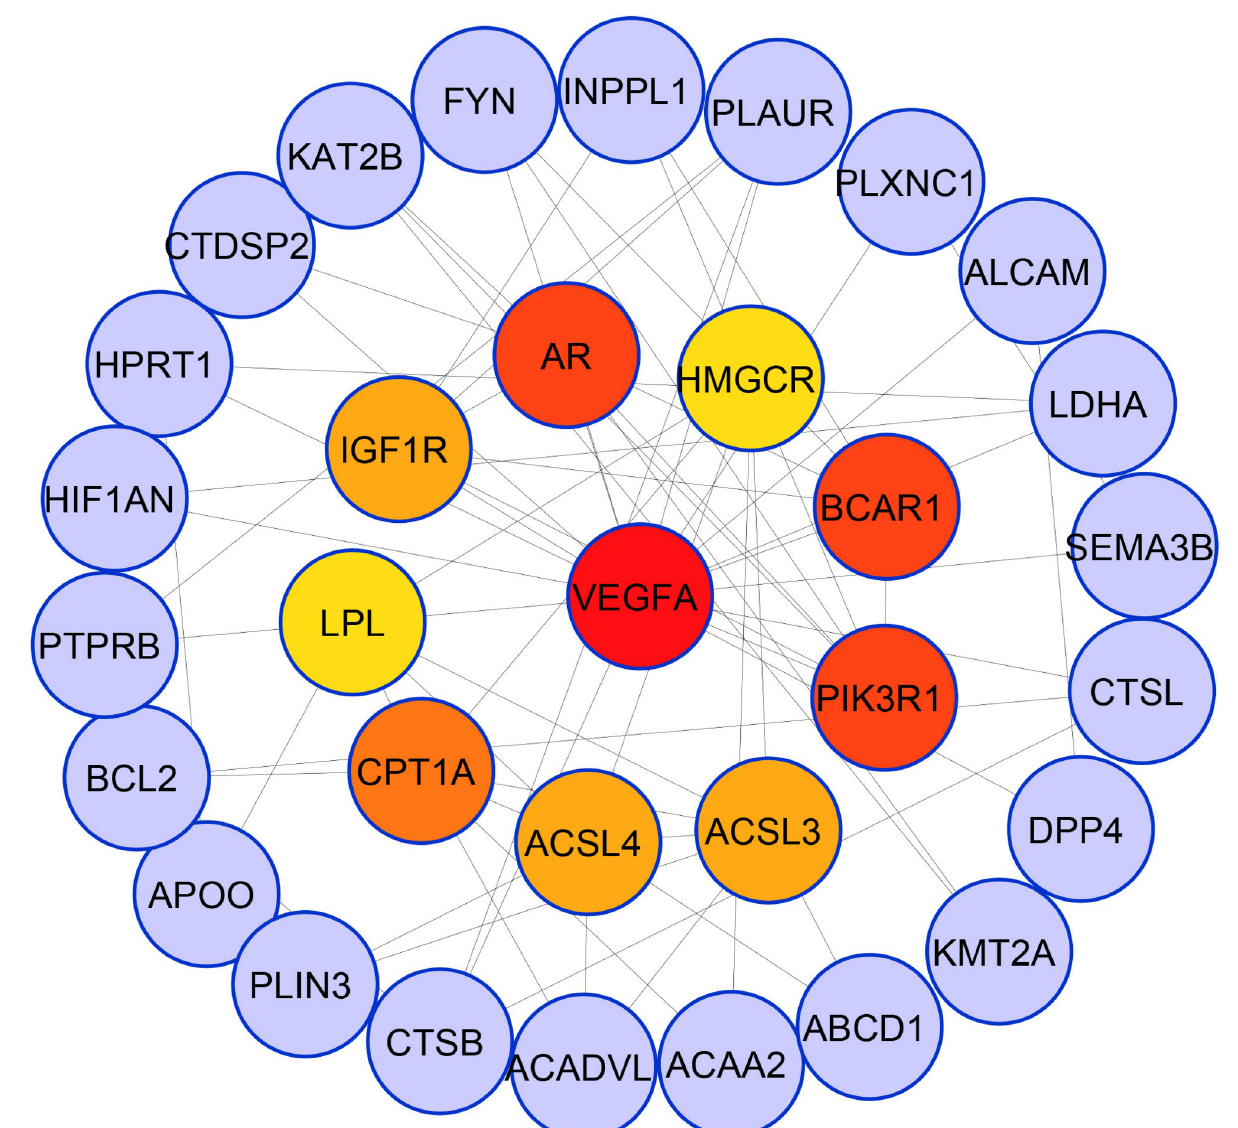
Fig 7. The simplified PPI network depicting the hub proteins. The ten most significant hub proteins are ranked with red to the yellow-colored gradient.